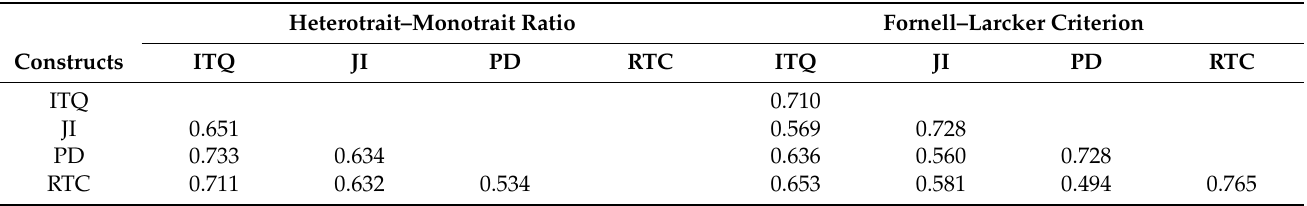
Table 3. Discriminant